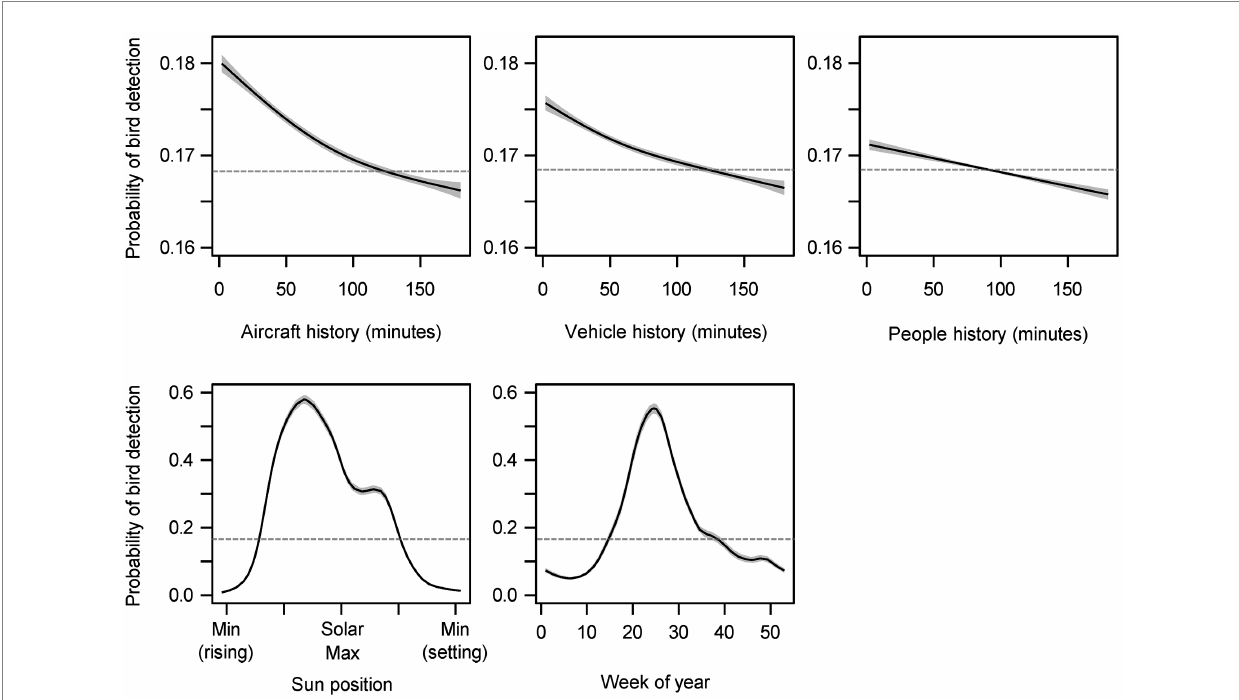
FIGURE 3 Partial effects plots for smoothed terms included in the general additive model. The gray shaded areas represent 95% confidence intervals. Each modeled effect has been transformed by the logistic function and shifted by the model intercept. The model intercept (0.168) is represented by the gray dashed horizontal line, and sections of the spline that are above or below this baseline indicates that the variable has a positive or negative impact, respectively, on bird detection probability at these